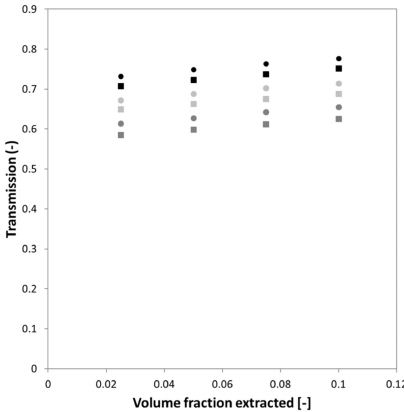
Figure 9. Transmission versus the volume fraction taken form the inlet. Results are shown for a channel height of 50 (circles) and 100 (squares) µ m and for three different bulk particle volume fractions: 0.1 (dark grey); 0.3 (light grey); and, 0.5